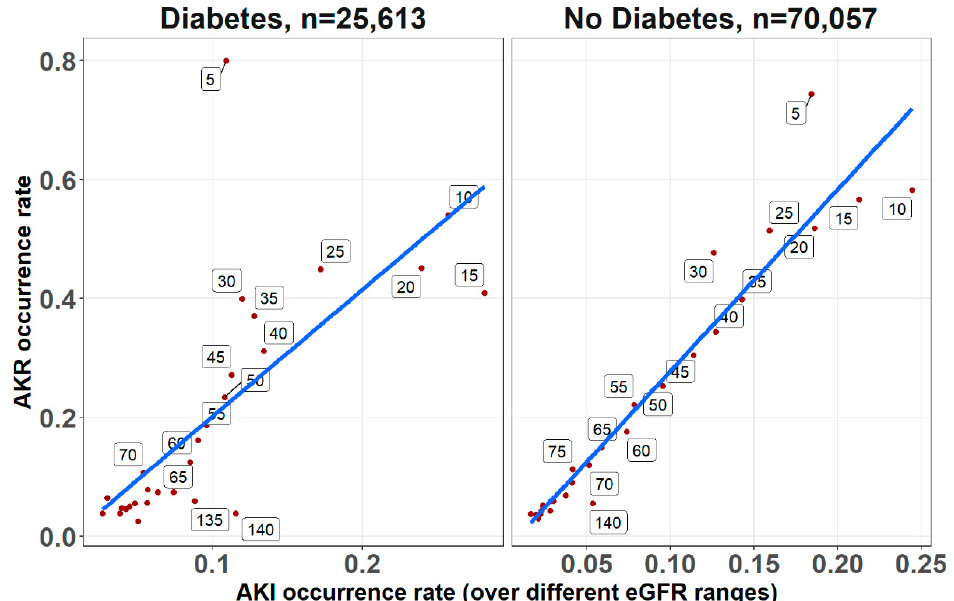
Figure 4. The correlations between AKI and AKR occurrence rates for diabetics and non-diabetic patients, determined across the range of baseline eGFR upon admission (at 5 mL/min/1.73 m 2 intervals, denoted for each point along the regression lines), irrespective to glucose levels. Trend lines for the Pearson’s correlation coefficients are shown (r = 0.96 and r = 0.73 for non-diabetic and diabetic respectively, p < 0.001 for both).